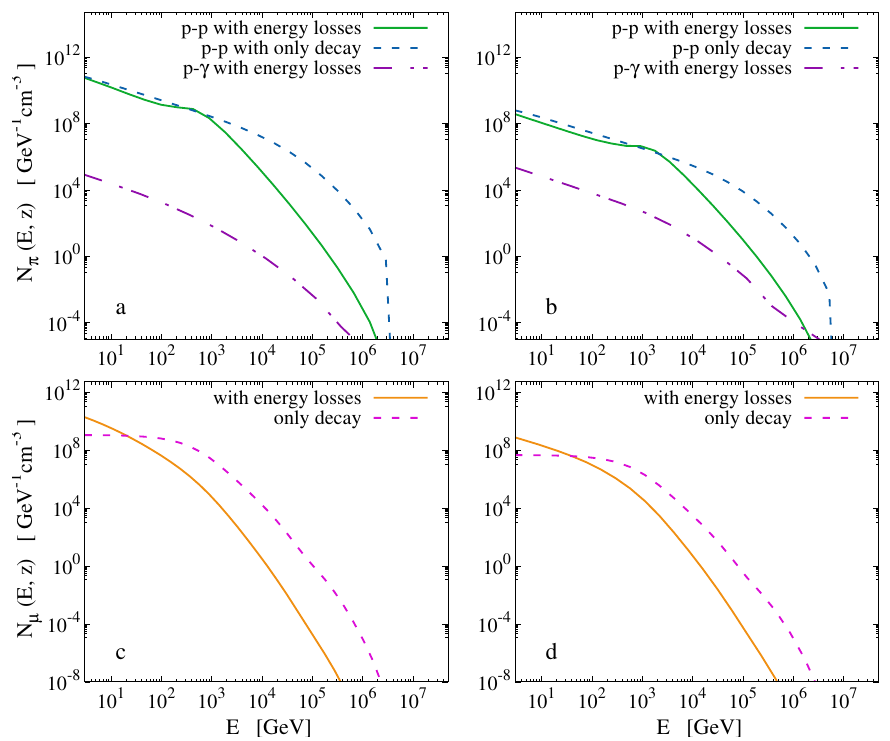
Figure 5. Energy distributions for pions ( π ± ) ( a , b ) and muons ( µ ± ) ( c , d ) produced in Cygnus X-1 ( a , c ) and LMC X-1 ( b , d ). Particle production takes place at z 0 , where evident is the effect of the energy-loss interactions to the particle distributions (solid lines) in comparison to the case where only decay occurs (dashed